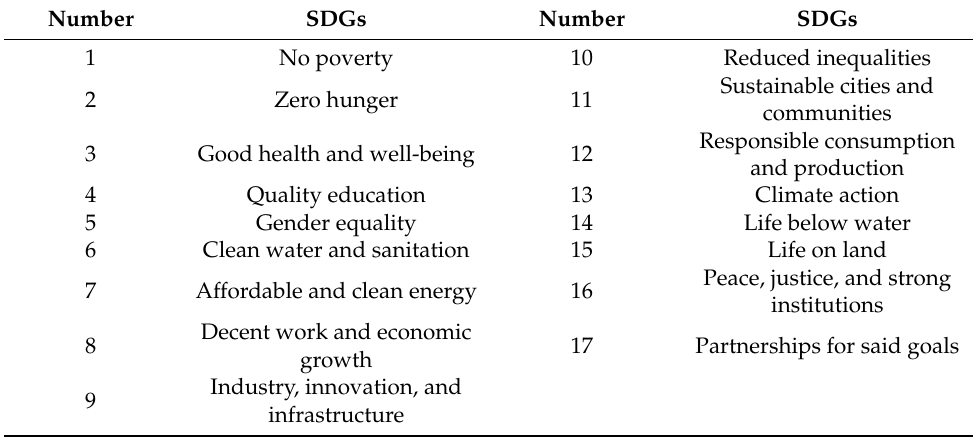
Table 3. List of Sustainable Development Goals